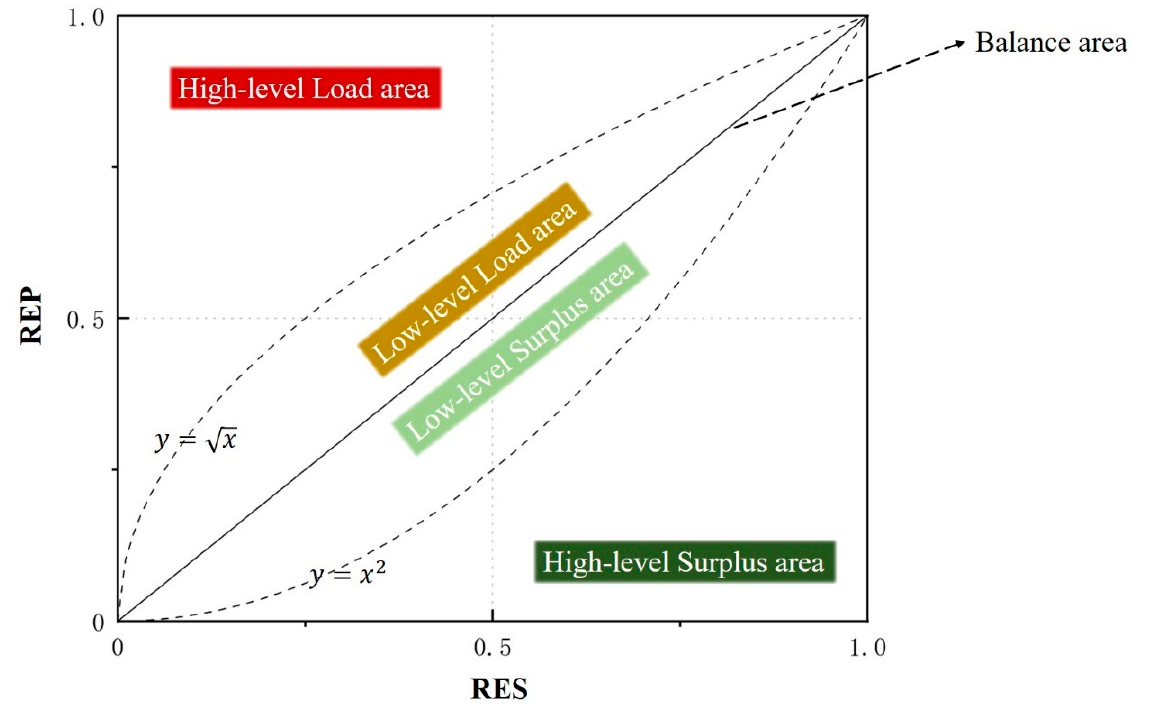
Figure 2. Coupling curve of RES and REP and partition states of RECC.